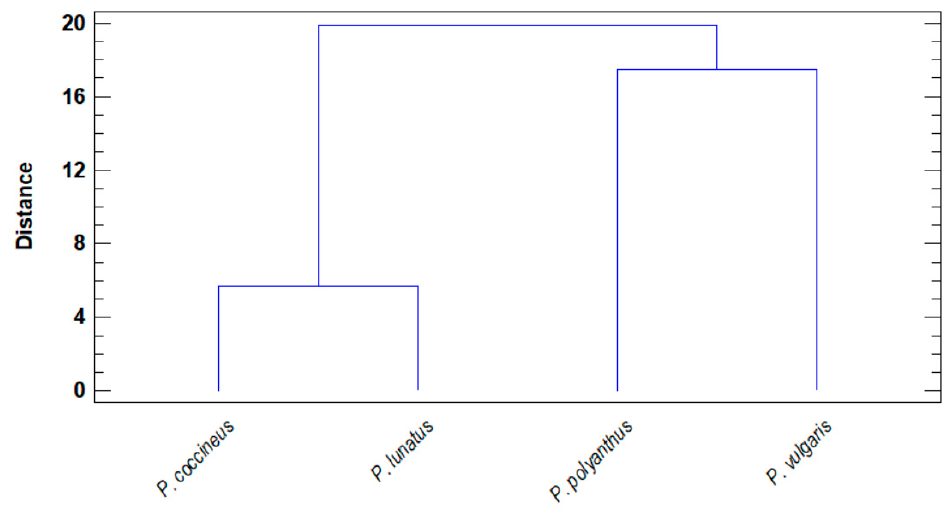
Figure 2. Dendrogram of the closest Phaseolus species based on free essential amino acids.